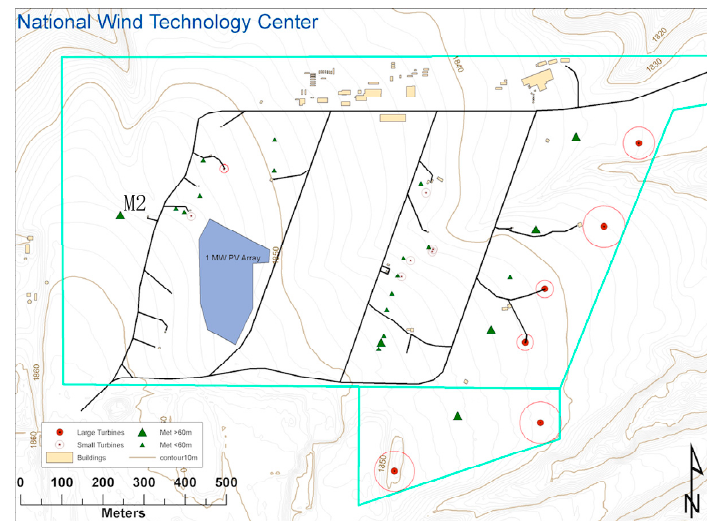
Figure 1. The geographical location of date measurement in NWTC.